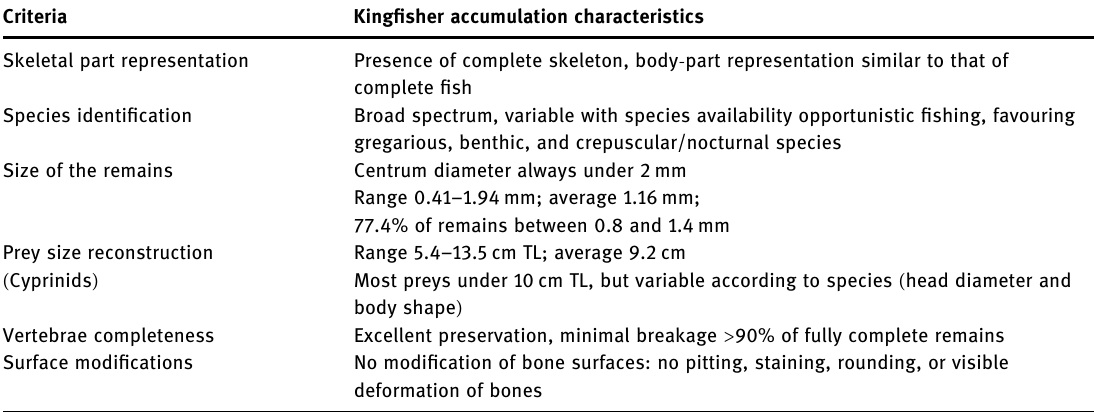
Table 7: Criteria for identifying a King fi sher pellets assemblage